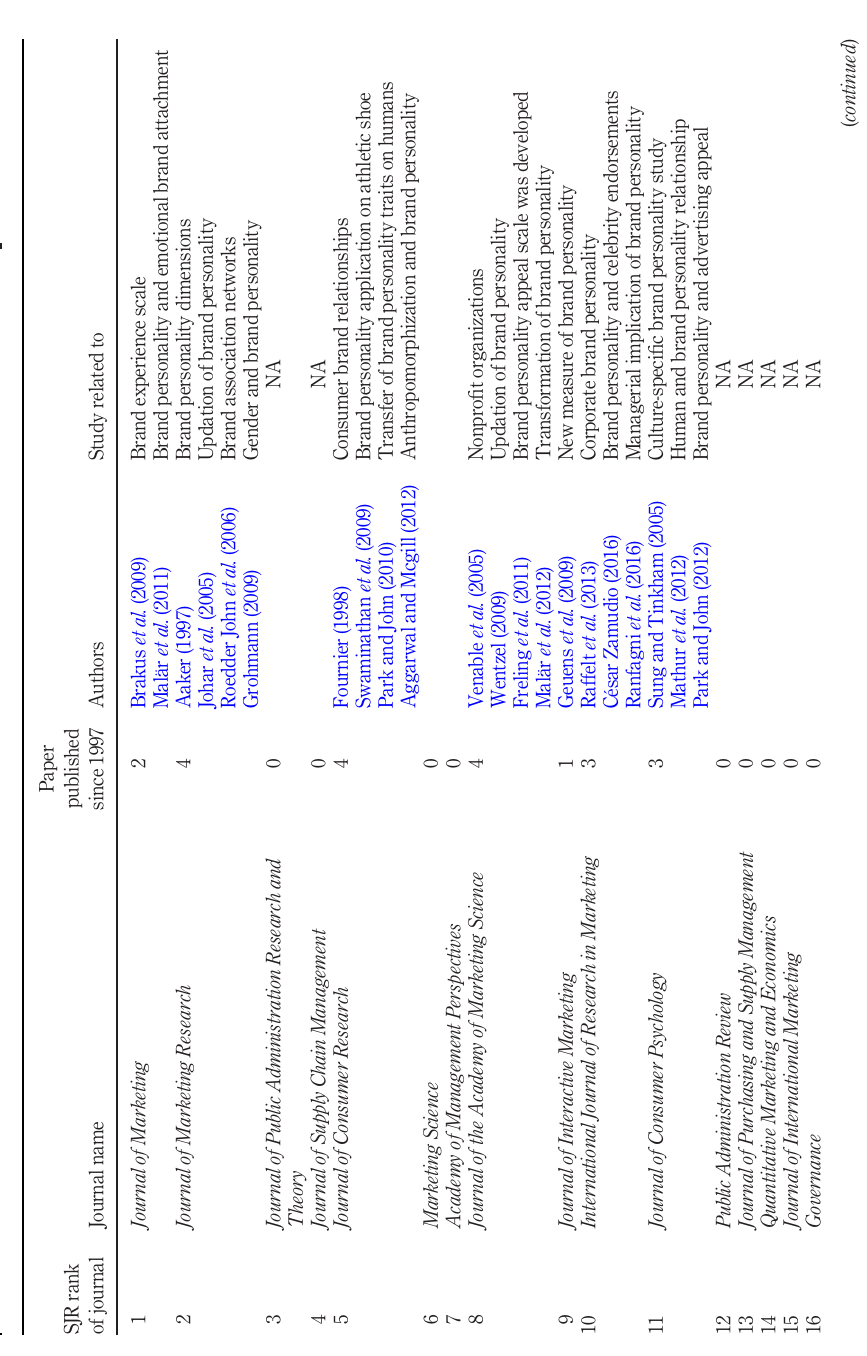
Table II. Brand personality studies in top journals after